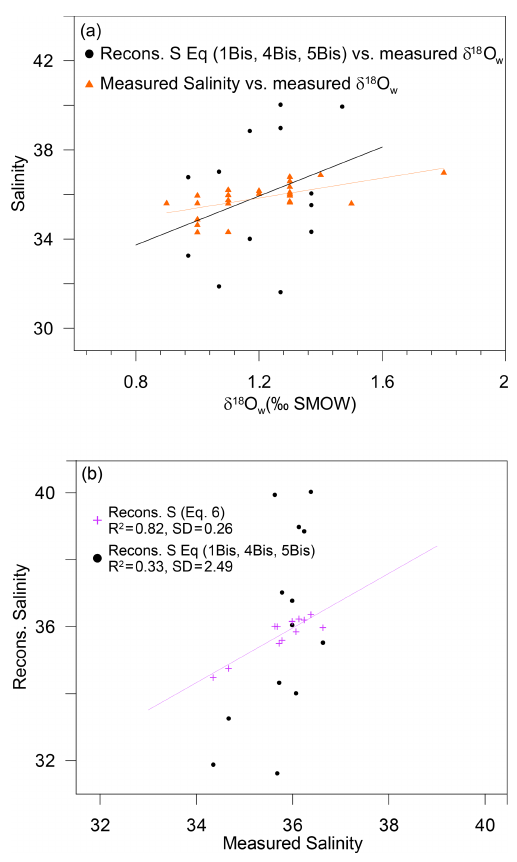
Figure 6. (a) Measured salinity (orange triangles) and recon- structed salinity based on Eqs. (1Bis), (4Bis) and (5Bis) from the present study (black dots) plotted versus measured δ 18 O w . (b) Re- constructed salinity based on (1) successive reconstructions using Eqs. (1Bis), (4Bis) and (5Bis) from the present study (black dots) and (2) direct linear fit (Eq. 6) based on the same measured vari- ables (Mg / Ca and δ 18 O c ) (purple crosses) plotted versus measured